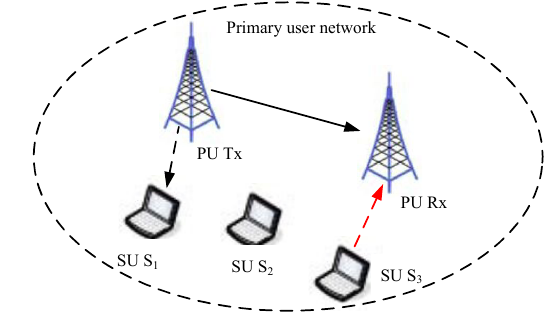
Figure 1. Merits of cooperative spectrum